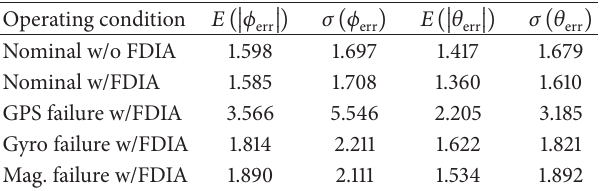
Table 2: Statistics of UIF-based fault tolerant attitude estimation.